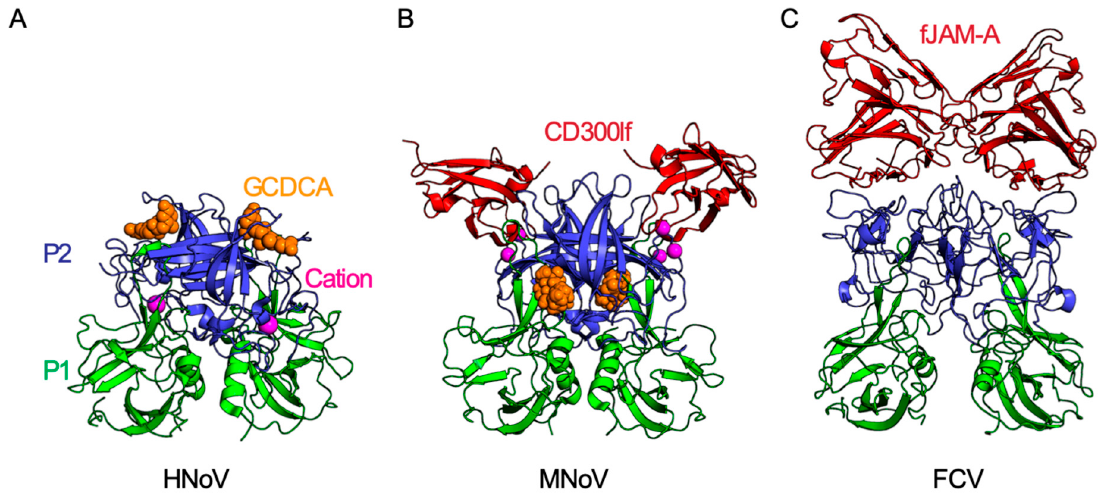
Figure 2. Molecular interactions of calicivirus capsid proteins. Each calicivirus has T = 3 icosahedral symmetry and is comprised of 90 VP1 dimers. Each VP1 capsid monomer is comprised of a shell (S) and a protruding (P) domain. The P domain is further subdivided into an apical P2 domain (blue) and a P1 domain (green) which connects the more variable P2 to the shell domain. ( A ) The secondary bile salt glycochenodeoxycholic acid (GCDCA; shown as orange space-filling model) binds to the apical region of the P2 domain of human norovirus (HNoV) GII.10 (PDB ID: 6GW1) [38]. This binding site partially overlaps with the HBGA binding site on HNoVs (not shown). ( B ) MNoV P2 binds the CD300lf receptor (red) at 1:1 stoichiometry (PDB IB: 6E47). Both cations (magenta) and GCDCA (orange)